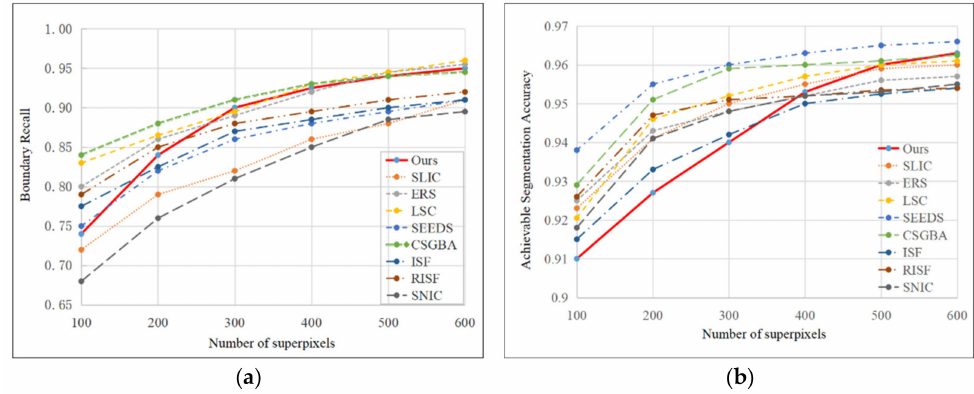
Figure 12. ( a , b ) Boundary Recall and Achievement Segmentation Accuracy of the superpixel methods on the BSDS500 dataset. The SEEDS, SLIC, ERS and LSC are examples of the classical methods. CSGBA [20], ISF [21], RISF [22] and SNIC [23] are the examples of the state-of-the-art methods.